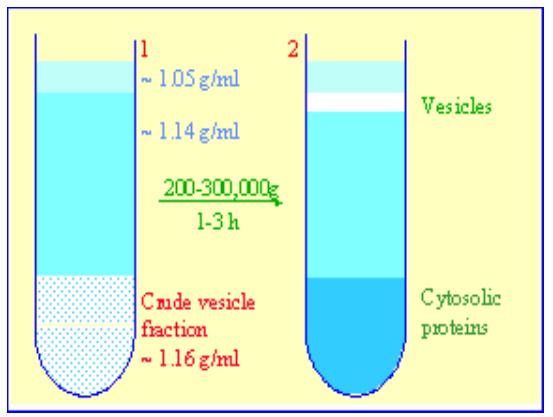
FIGURE 1. Separation of vesicles and cytosolic proteins from mammalian cultured cells by flotation in a discontinuous iodixanol